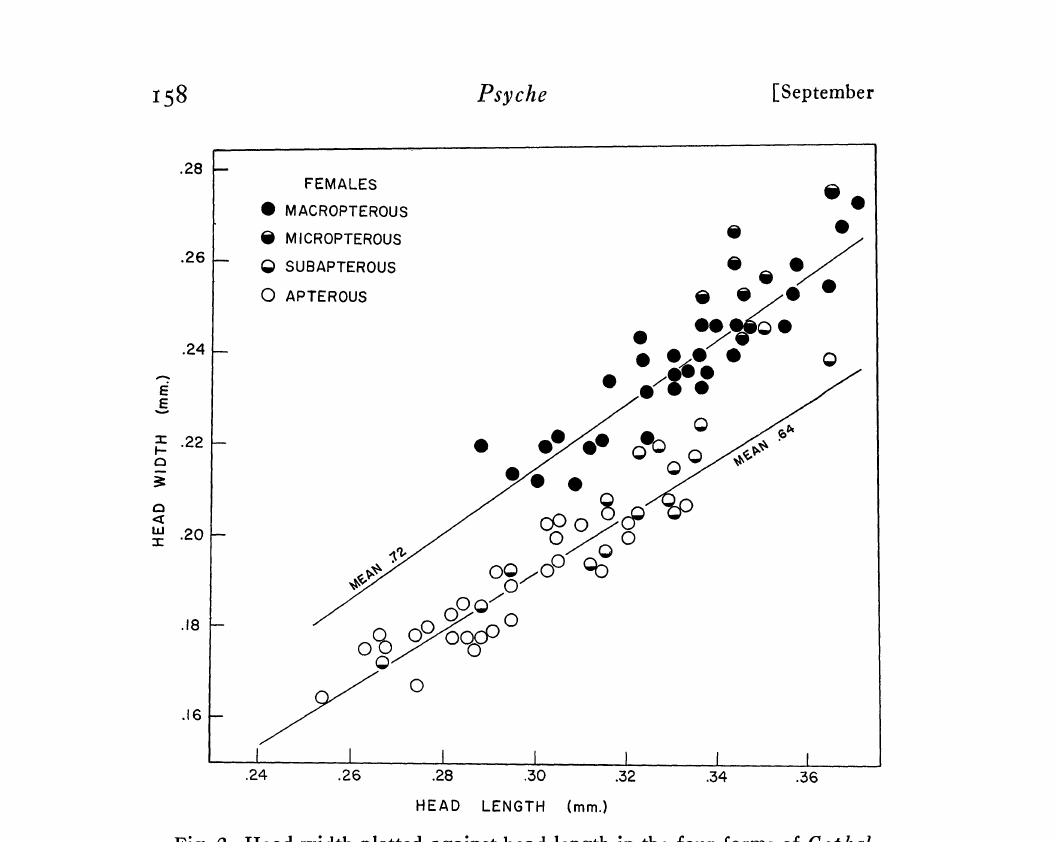
Fig. 2. Head width plotted against head length in the four forms of Cephal- onomia perpusilla females. the eyes very slightly smaller but the ocelli not noticeably